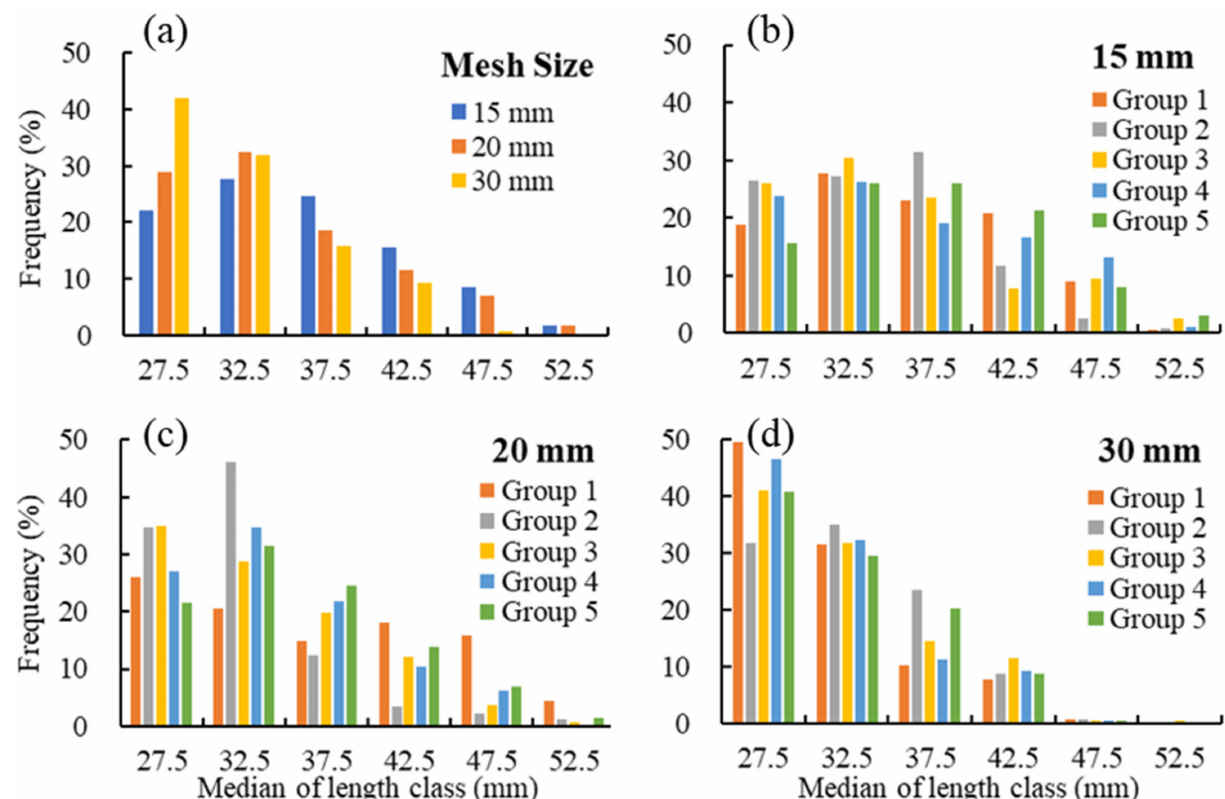
Figure 3. Histogram of the frequencies for each of the length classes obtained per replicate. The median was used as a length descriptor for each of the replicates. ( a ) A plot of aggregated values for each panel mesh size; ( b – d ): A plot of values for mesh sizes 15 mm, 20 mm, and 30 mm,